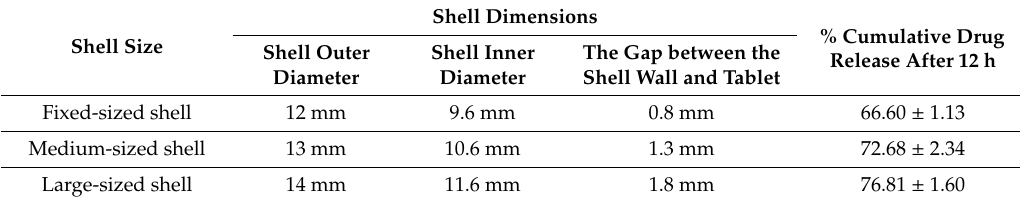
Table 4. Influence of di ff erent sizes of 3D printed controlled-release shells on cumulative drug release after 12 h with phosphate bu ff er (pH 6.8) as dissolution media at temperature 37 ± 0.5 ◦